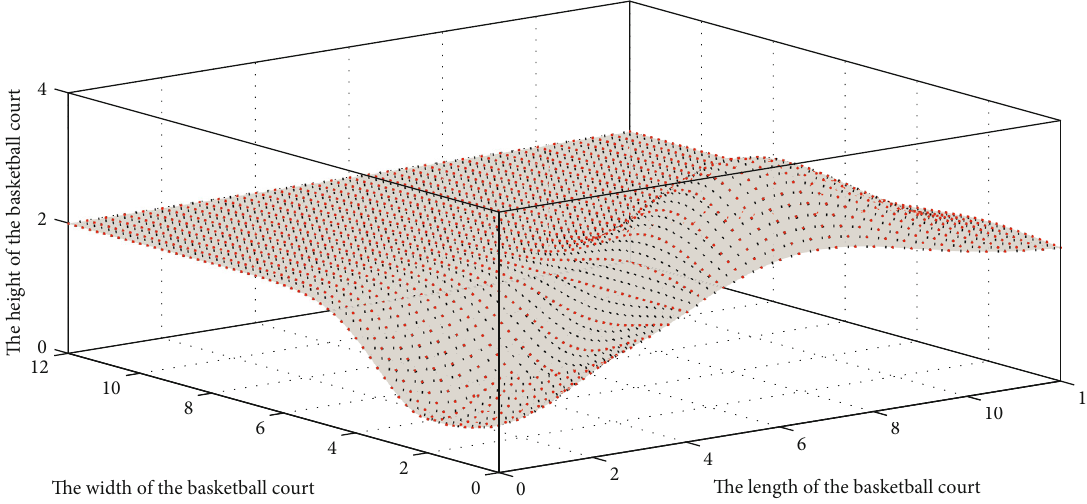
Figure 7: Basketball trajectory based on di ff usion equation